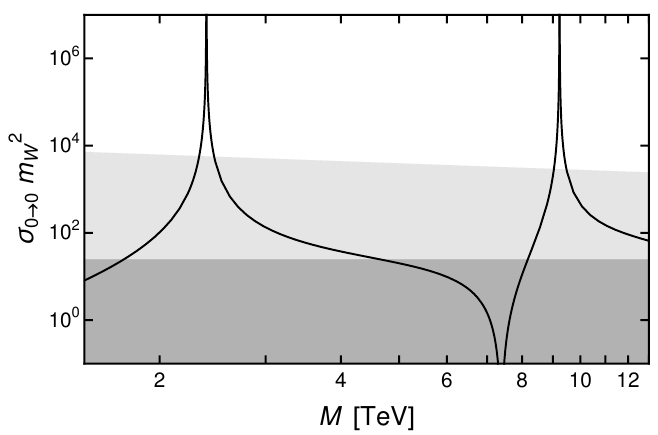
Figure 5 . Neutral-wino elastic cross section (cid:27) 0 ! 0 at zero energy as a function of the wino mass M . The peaks have (cid:12)nite maxima that cannot be seen in the plot. In a range of M where (cid:27) 0 ! 0 is above the darker shaded region ( (cid:27) 0 ! 0 < 8 (cid:25)=m 2 ), the ZREFT for neutral and charged winos W is applicable. In a range of M where (cid:27) 0 ! 0 is above the lighter shaded region ( (cid:27) 0 ! 0 < 8 (cid:25)= (cid:1) 2 ), a simpler ZREFT for neutral winos only is applicable.